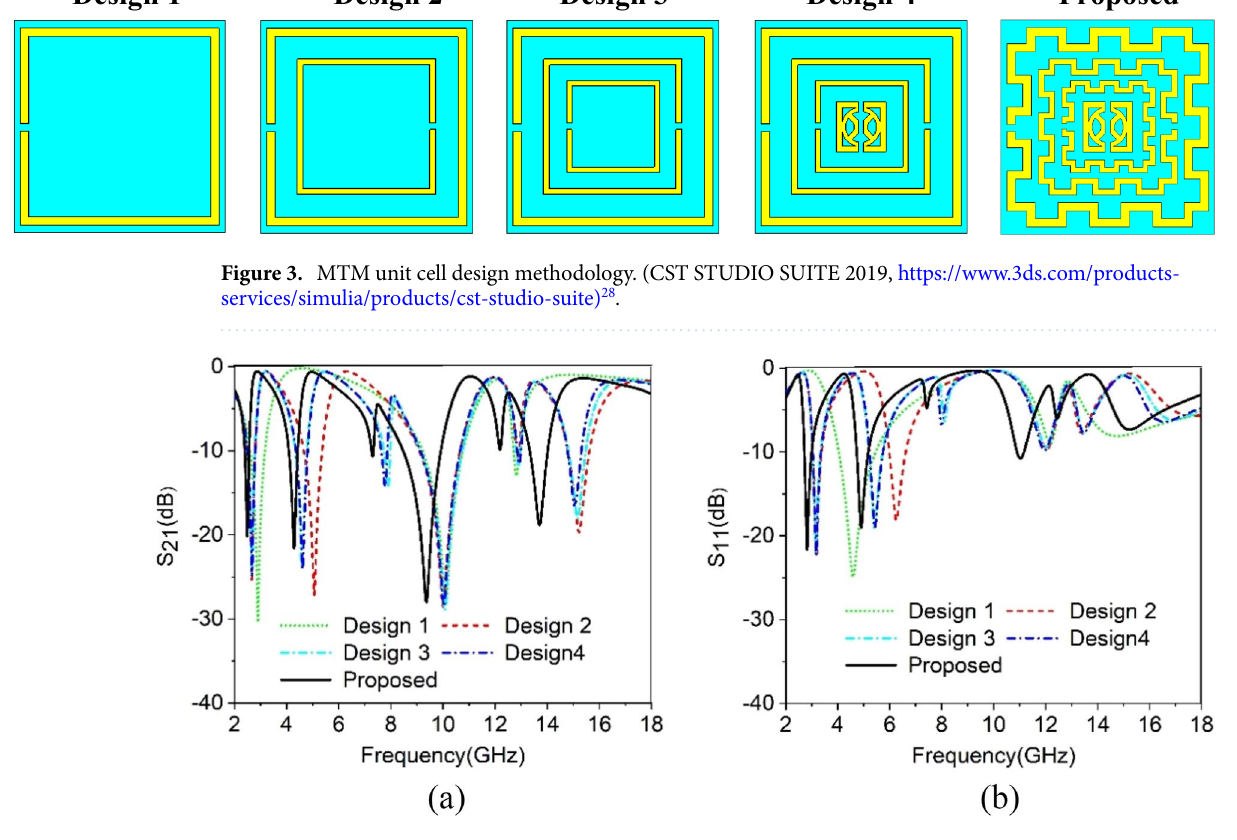
Figure 4. ( a ) Transmission coefficient(|S 21 |) of proposed MTM unit cell (Design methodology). ( b ) Reflection coefficient(|S 11 |) for various changes in design (Design methodology).